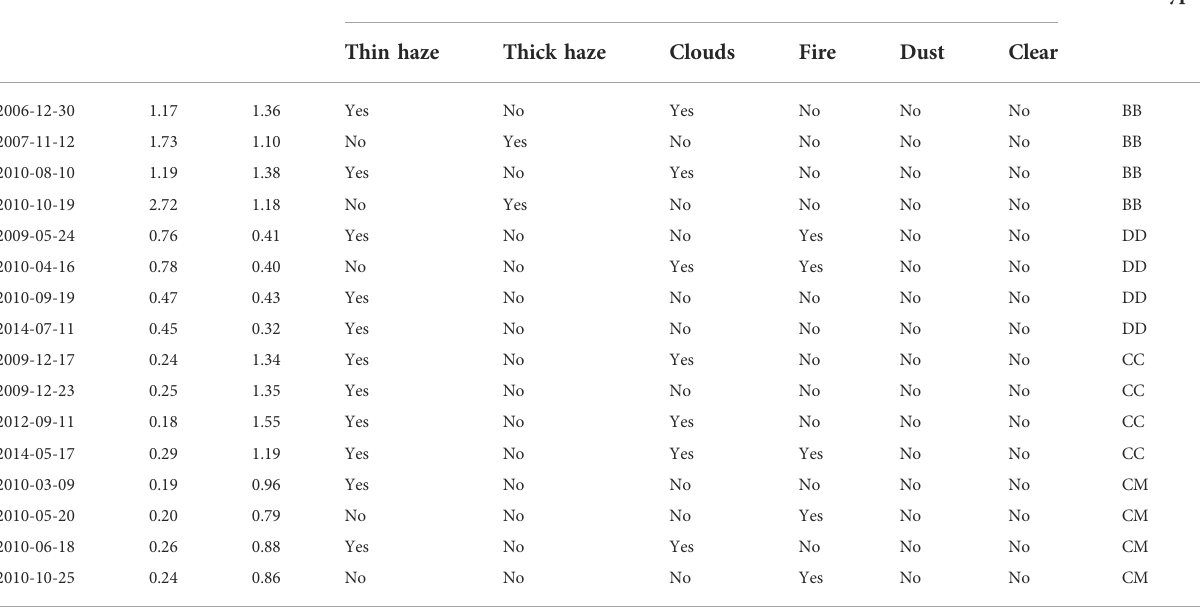
TABLE 6 Evaluation of GA aerosol types using AERONET AOD and AE for speci fi c events governed by known aerosol types; for all events, the GA classi fi cation did not assign the expected aerosol types. Date AOD AE